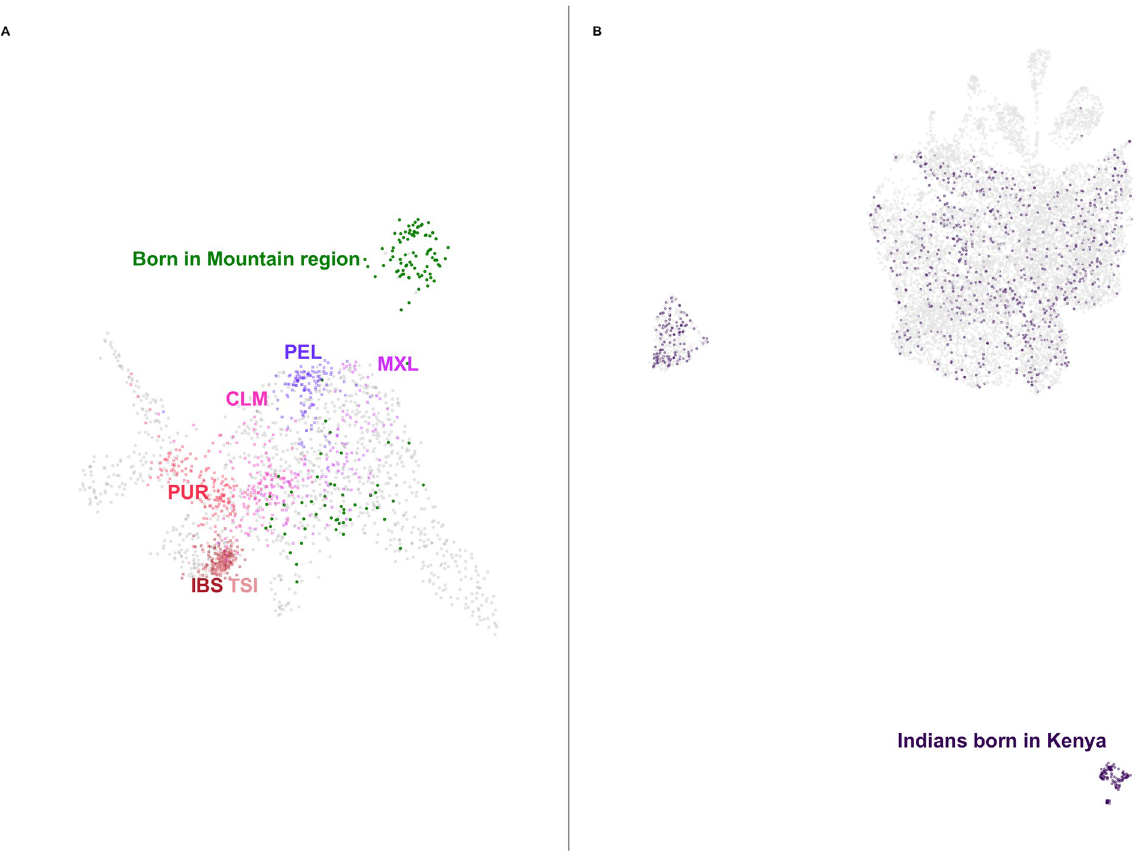
Fig 2. Applying UMAP to subsets of data can reveal deep population structure. ( A ) UMAP on the top 7 principal components of the self- identified Hispanic population of the HRS reveals a cluster. Colouring the points by birthplace shows they were born almost entirely in the Mountain region (in green) of the United States (New Mexico, Arizona, Colorado, Utah, Nevada, Wyoming, Idaho, and Montana). When populations from the 1KGP are projected onto the UMAP embedding they do not map to the cluster. Six 1KGP populations are presented: CLM, Colombian in Medellin, Colombia; IBS, Iberian in Spain; MXL, Mexican in Los Angeles, California; PEL, Peruvian; PUR, Puerto Rican; TSI, Toscani in Italy. S11 and S12 Figs present the same projection of individuals from the HRS coloured by estimated admixture proportions census region of birth, respectively. ( B ) UMAP on the top 8 principal components of the self-identified Asian populations of the UKBB creates clusters. Indian individuals born in Kenya (in purple) form one such cluster. A version coloured by self-identified ethnicity is presented in S13